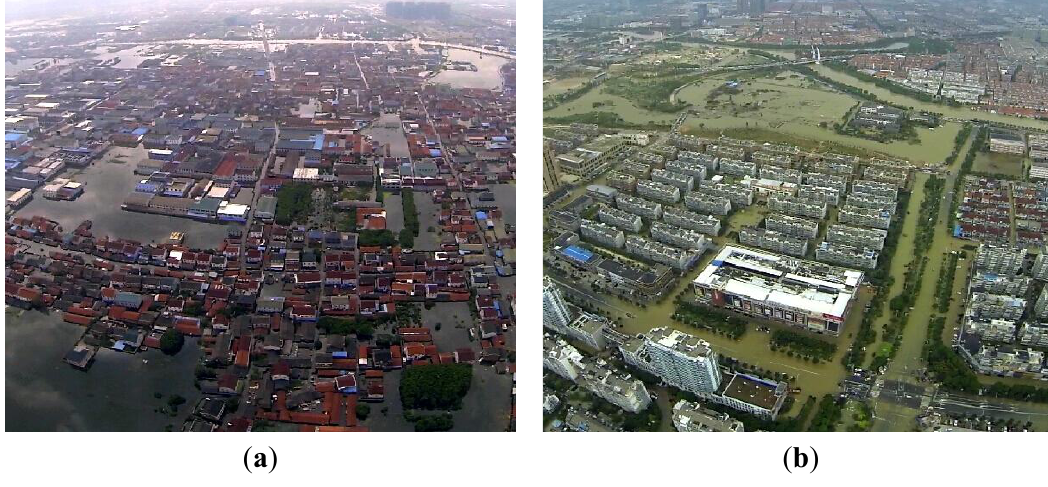
Figure 3. Typical flood depictions acquired by wide field camera on board the UAV: